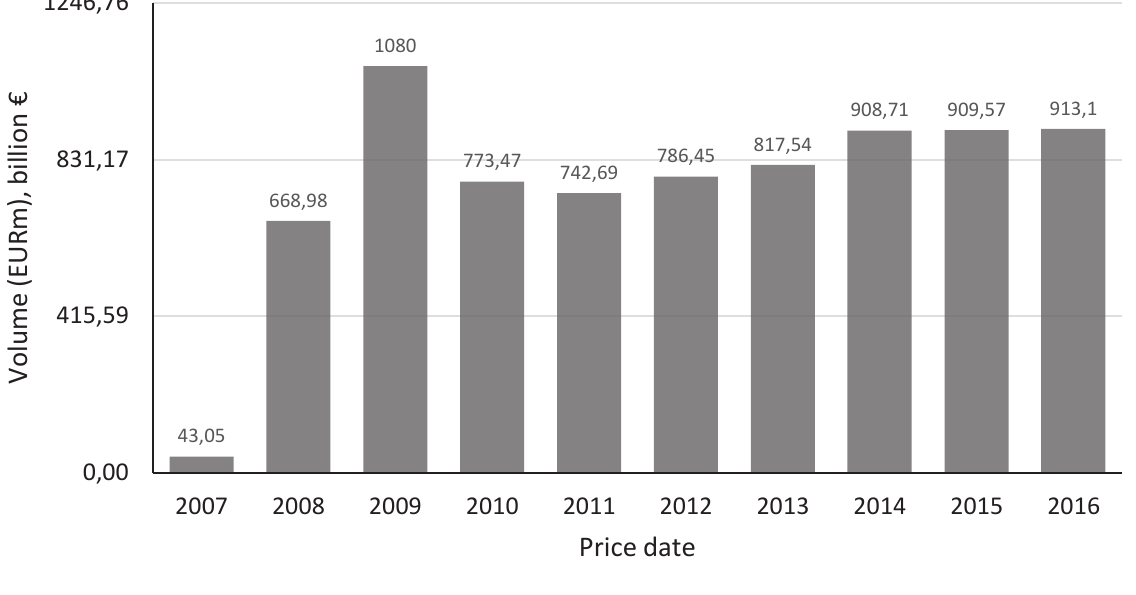
Figure 1. Volume of issued bonds by